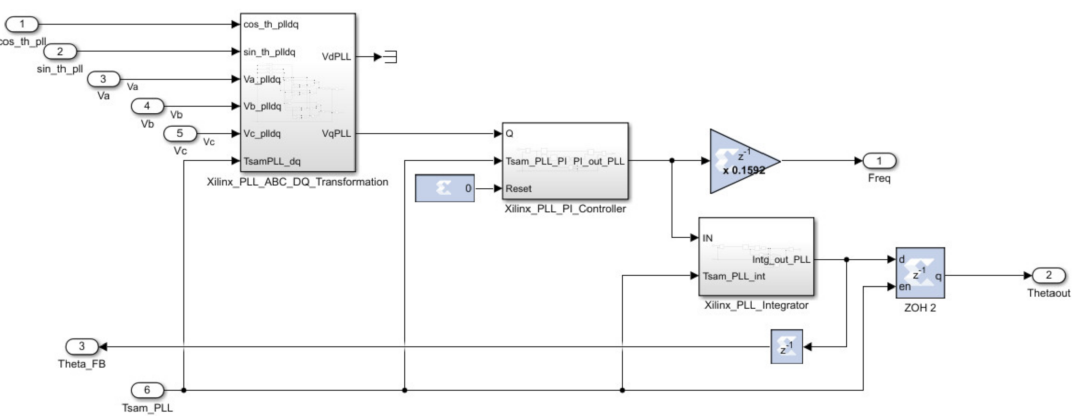
Figure 12. Phase lock loop (PLL).